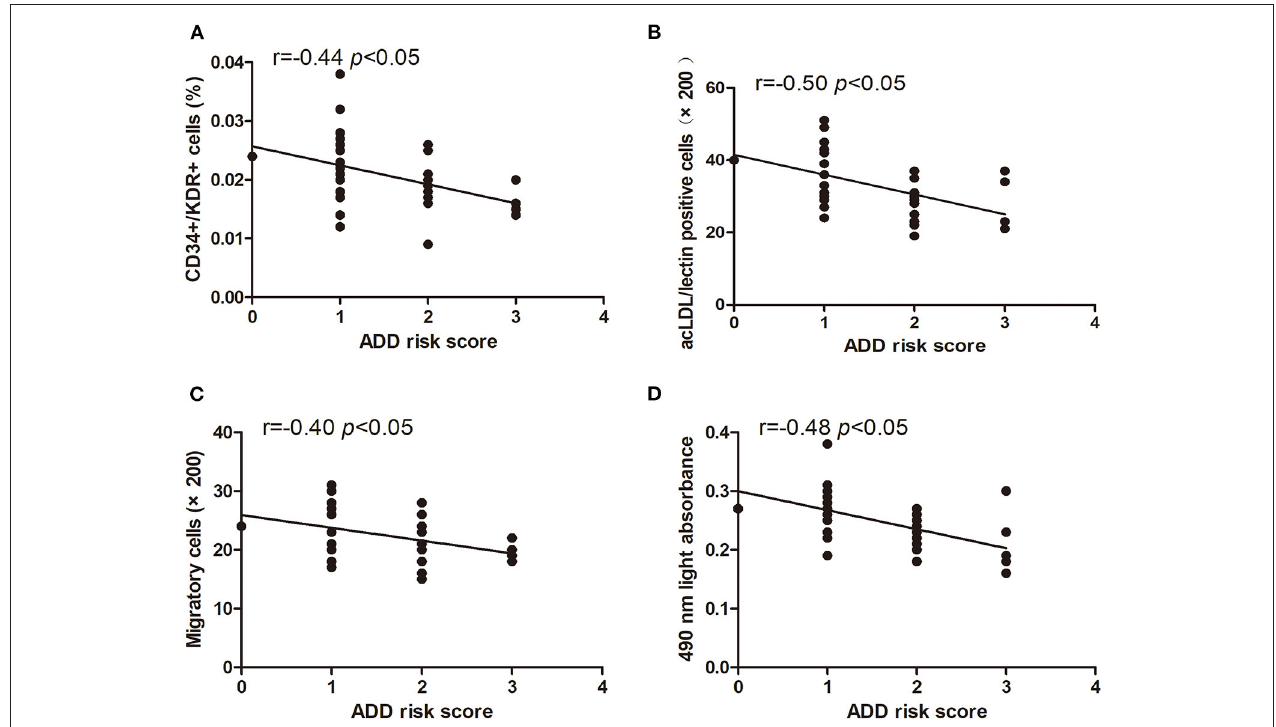
FIGURE 3 | Pearson correlation ratios were used to analyze the relationship between the number or function of EPCs and ADD-RS. The CD34 + KDR + positive cells (A) and DiI-acLDL/lectin positive cells (B) significantly correlated with ADD-RS. The migratory (C) and proliferative (D) activities of EPCs were related to ADD-RS.